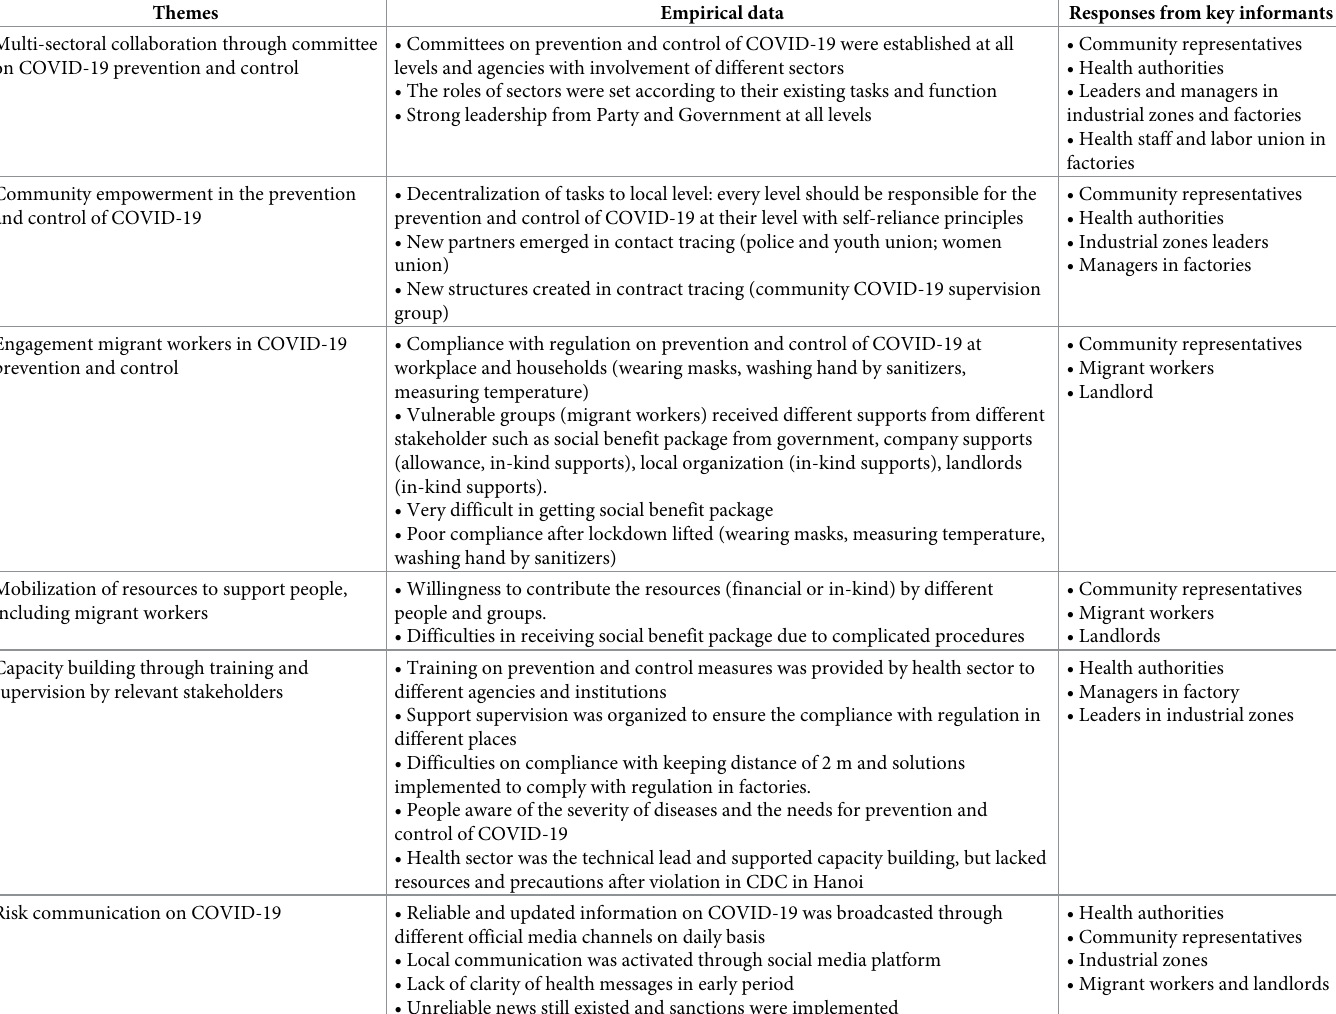
Table 2. Themes identified from